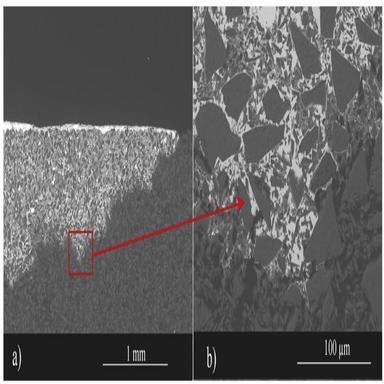
BSE images of SiCp-C preform microstructure infiltrated with liquid Si-Ir eutectic alloy at T = 1250 °C. a) Global microstructure of infiltrated area and b) detail of the infiltration front at higher magnification.